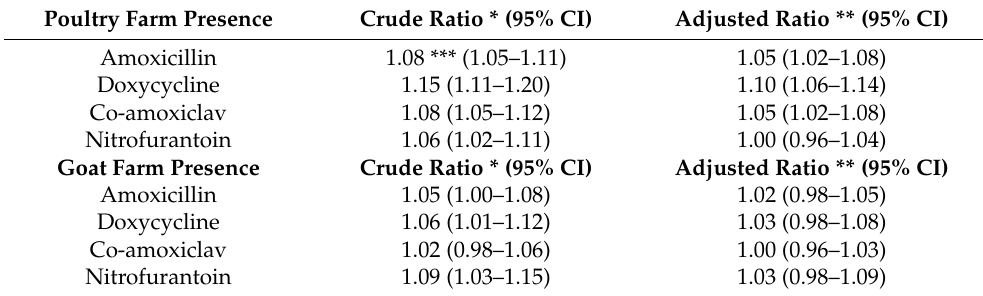
Table 4. Associations between presence of poultry or goat farms and antibiotic use per type of antibiotic from negative binomial